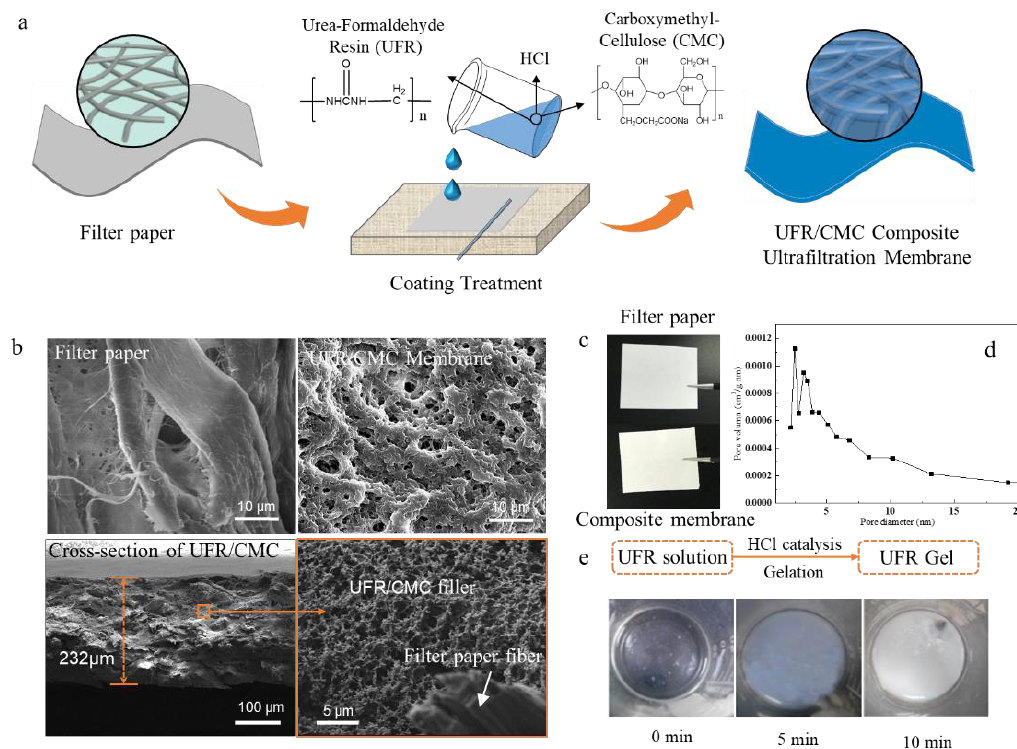
Figure 1. ( a ) Schematic illustration of preparation of the UFR / CMC composite ultrafiltration membrane ( b ) morphological images of the UFR / CMC composite ultrafiltration membrane ( c ) photos of filter paper and the composite ultrafiltration membrane ( d ) pore diameter distribution of the composite ultrafiltration membrane ( e ) changes in UFR gel degree over time with the addition of hydrochloric acid.